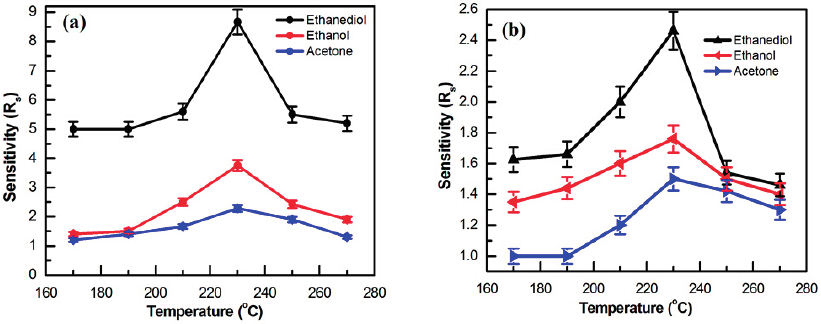
Figure 5. The gas sensitivity of ( a ) the La-SnO 2 NB and ( b ) the SnO 2 NB to 100 ppm gas from 170 °C to 270